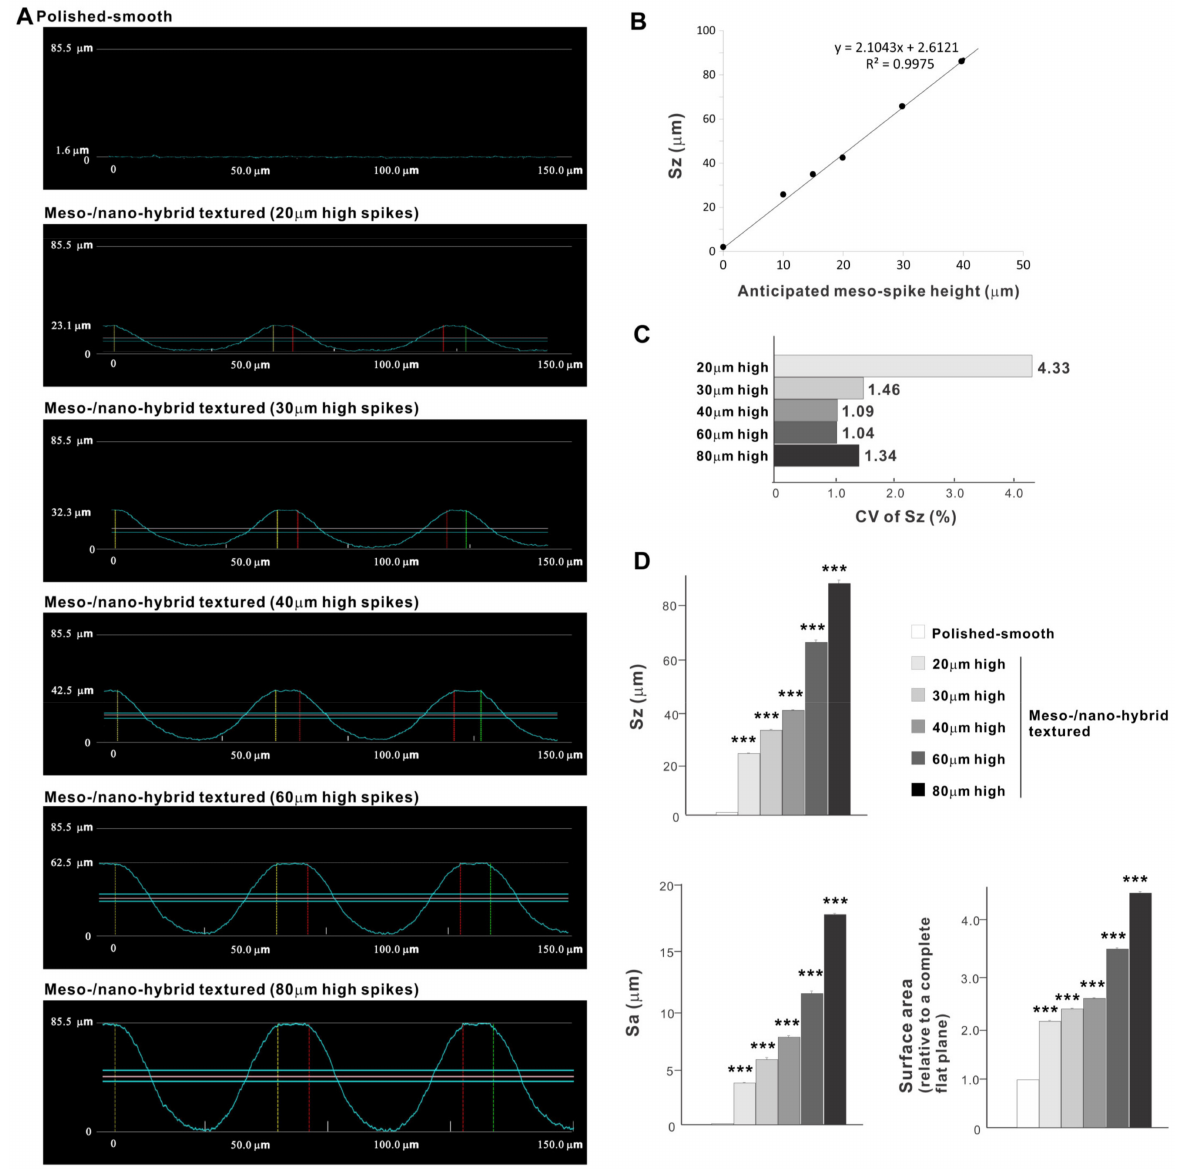
Figure 4. Quantitative surface analyses of the bio-inspired meso-/nano-scale hybrid textured zirconia. ( A ) Cross-sectional profile curves of the polished-smooth zirconia and the meso-/nano-scale textured zirconia with various heights of meso- spikes. ( B ) Sz (peak-to-valley roughness) plotted against the estimated/planned height of meso-scale spikes, showing a near-perfect linear correlation. ( C ) Coefficient of variation (CV) of Sz for different height designs of meso-scale spikes. CV (%) = (SD/Mean) × 100. ( D ) Quantitative topographical evaluations; Sz, Sa (average roughness), and surface area. *** p < 0.001, statistically significant difference compared with a polished